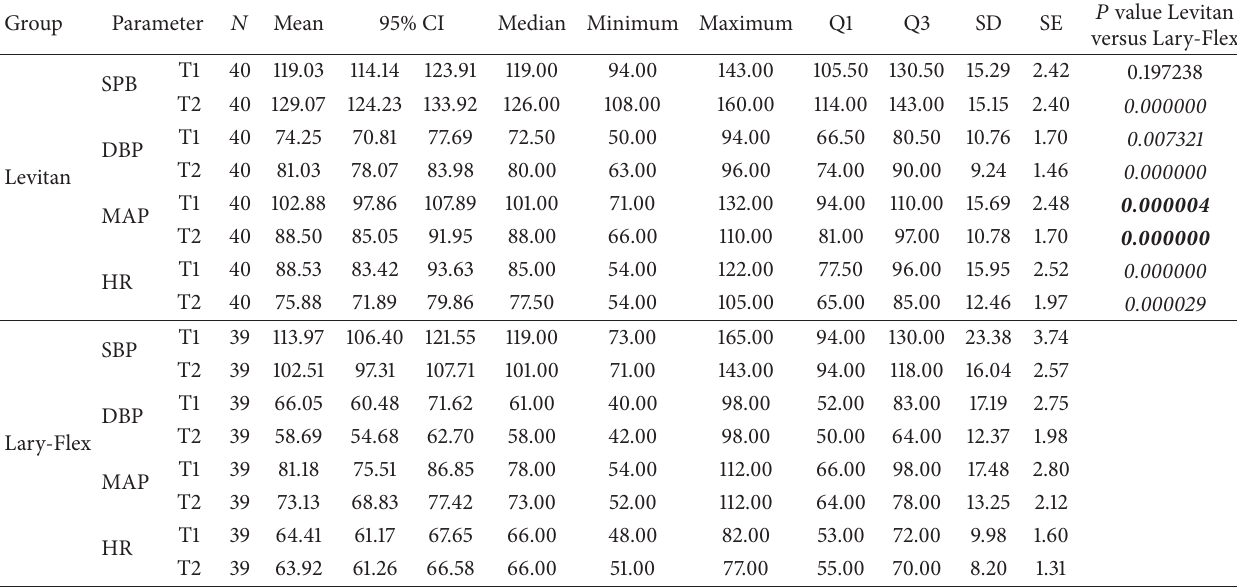
Table 6: Cardiovascular response to intubation